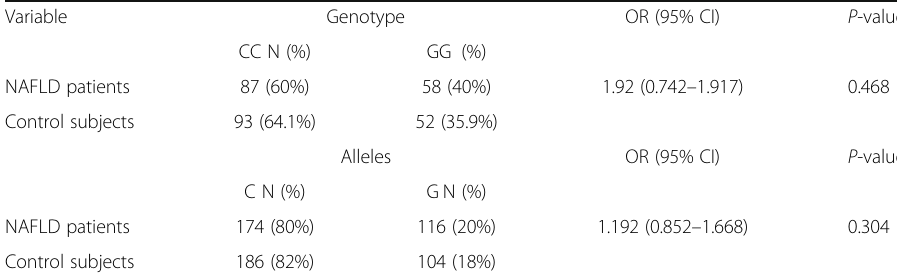
Table 2 Genotypic association of the Pro12Ala polymorphism with NAFLD Variable Genotype OR (95% CI) P -value CC N (%) GG (%) NAFLD patients 87